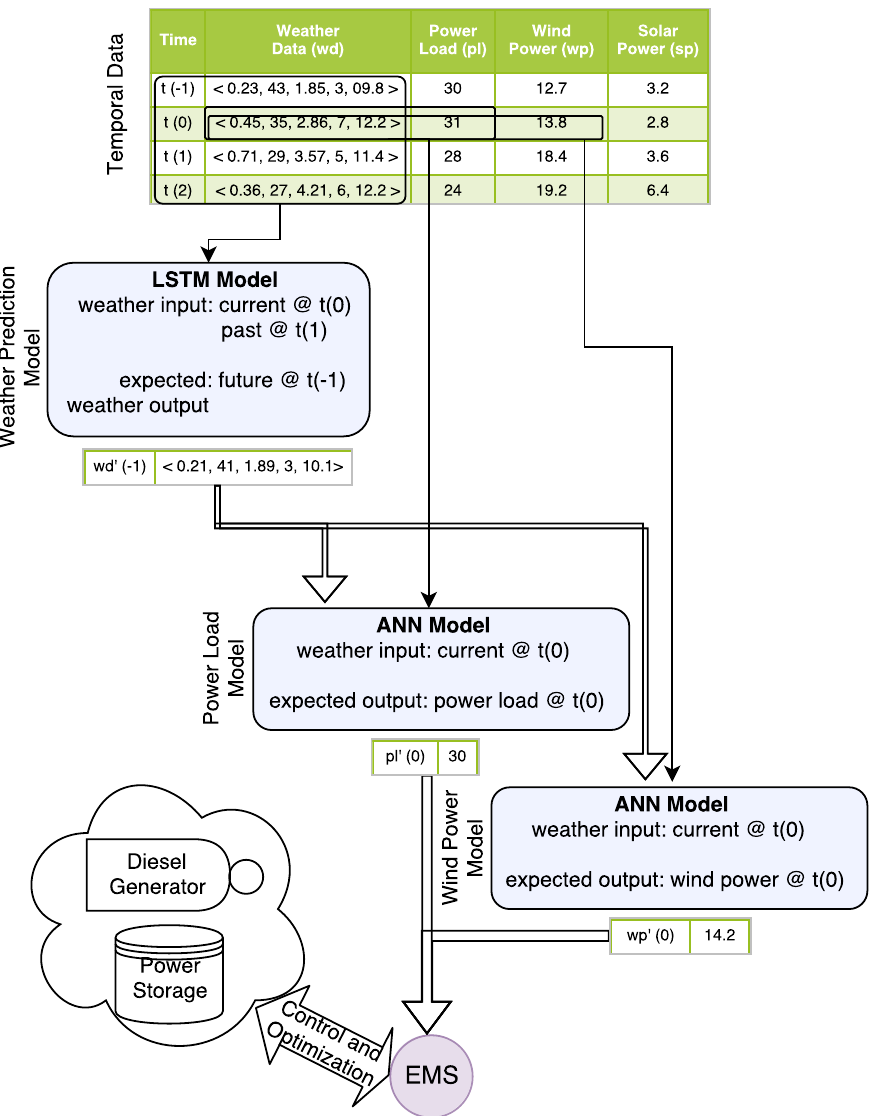
Figure 2. An illustration of the power prediction super-model. The weather conditions, power load and power generation data are showed in the Temporal Data table. The solid arrows indicate the use of data for the model training, the double arrows show the prediction of power load or power generation. While the illustration shows the overall energy microgrid management system (EMMS), we present only the details of the Long Short Term Memory and the Power Load Artificial Neural Networks models. The EMMS simply integrates the power load prediction and the power generation from the renewable